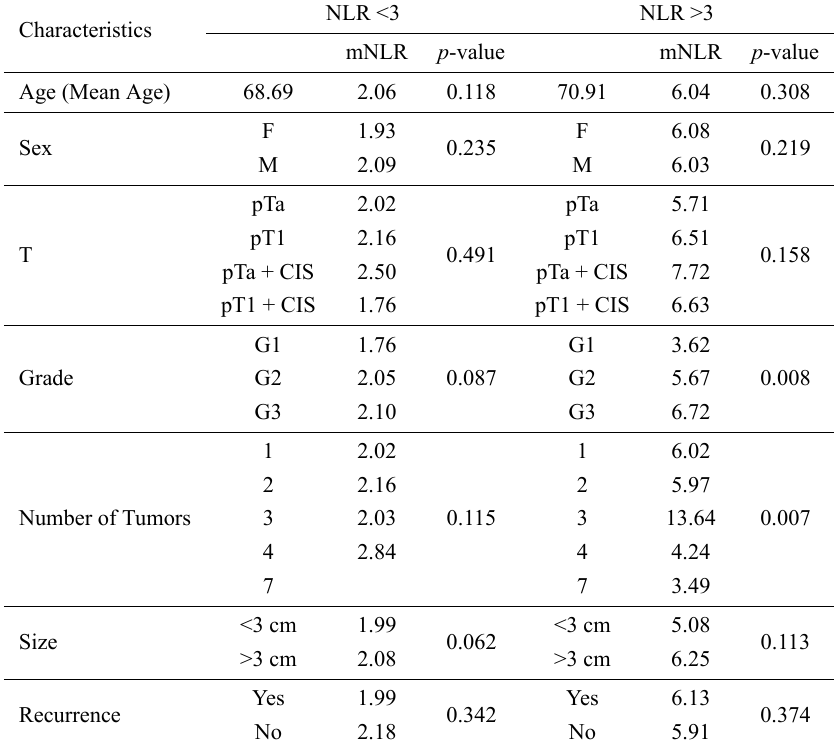
Table 1. Characteristics of 371 patients according to